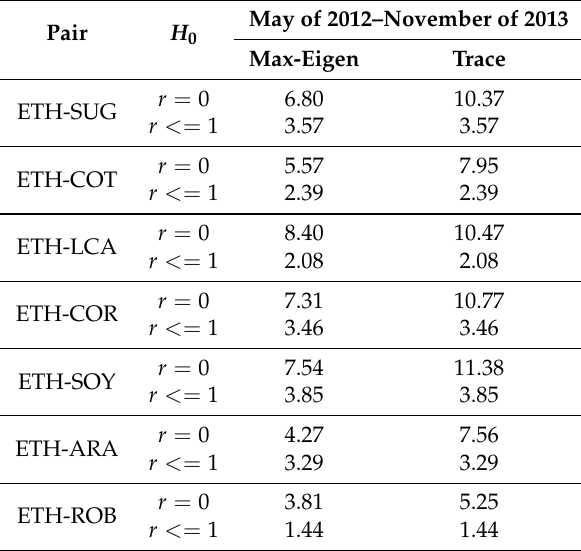
Table A3. The Johansen test for P 2 .